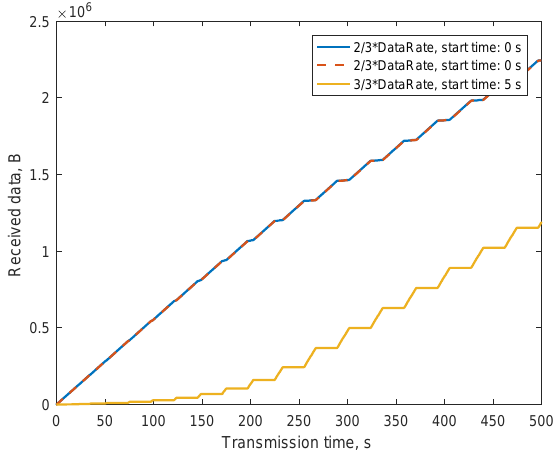
Figure 13. Scenario